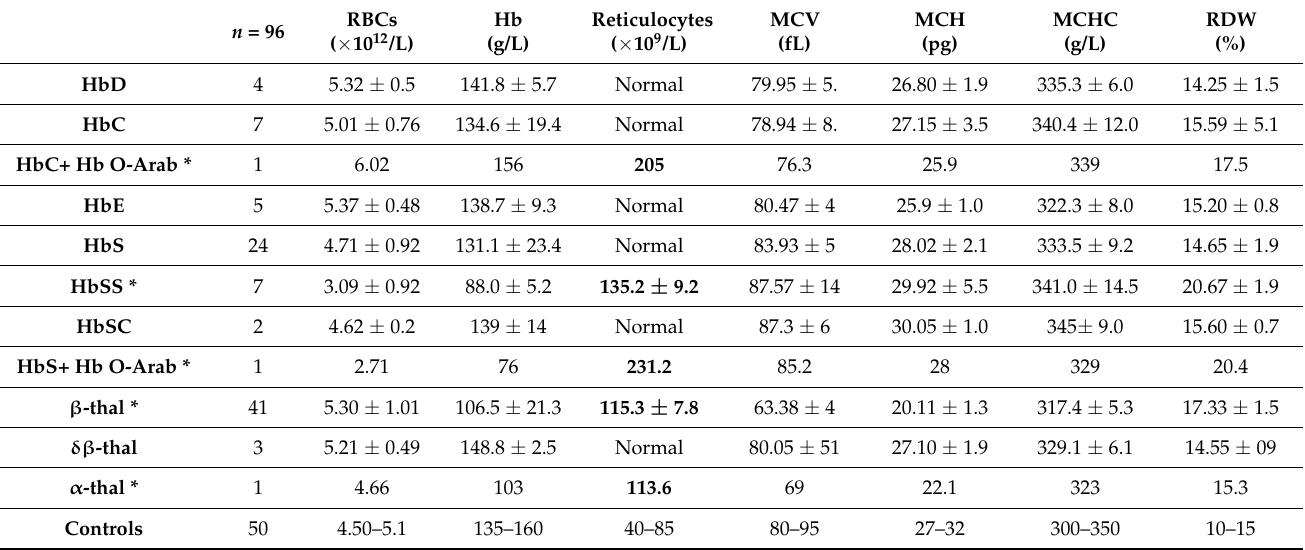
Table 1. Hematological parameters of the patients with hemoglobinopathies included in this